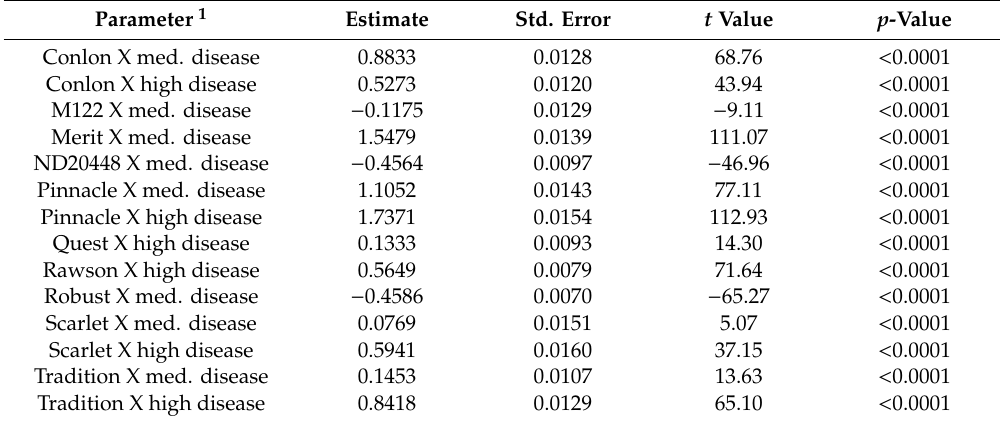
Table 5. Estimated intercept coe ffi cients, interaction terms with cultivars and fungicide application, by FHB severity